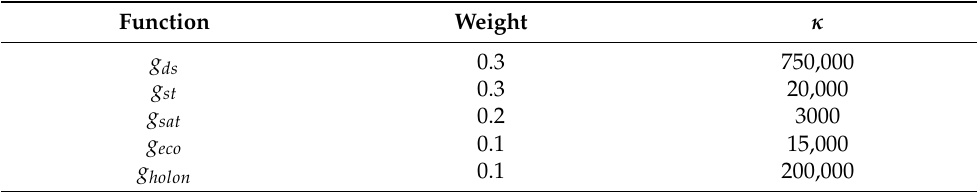
Table 3. Weight and sensitivity configurations for the individual sub-functions of the penalty function.